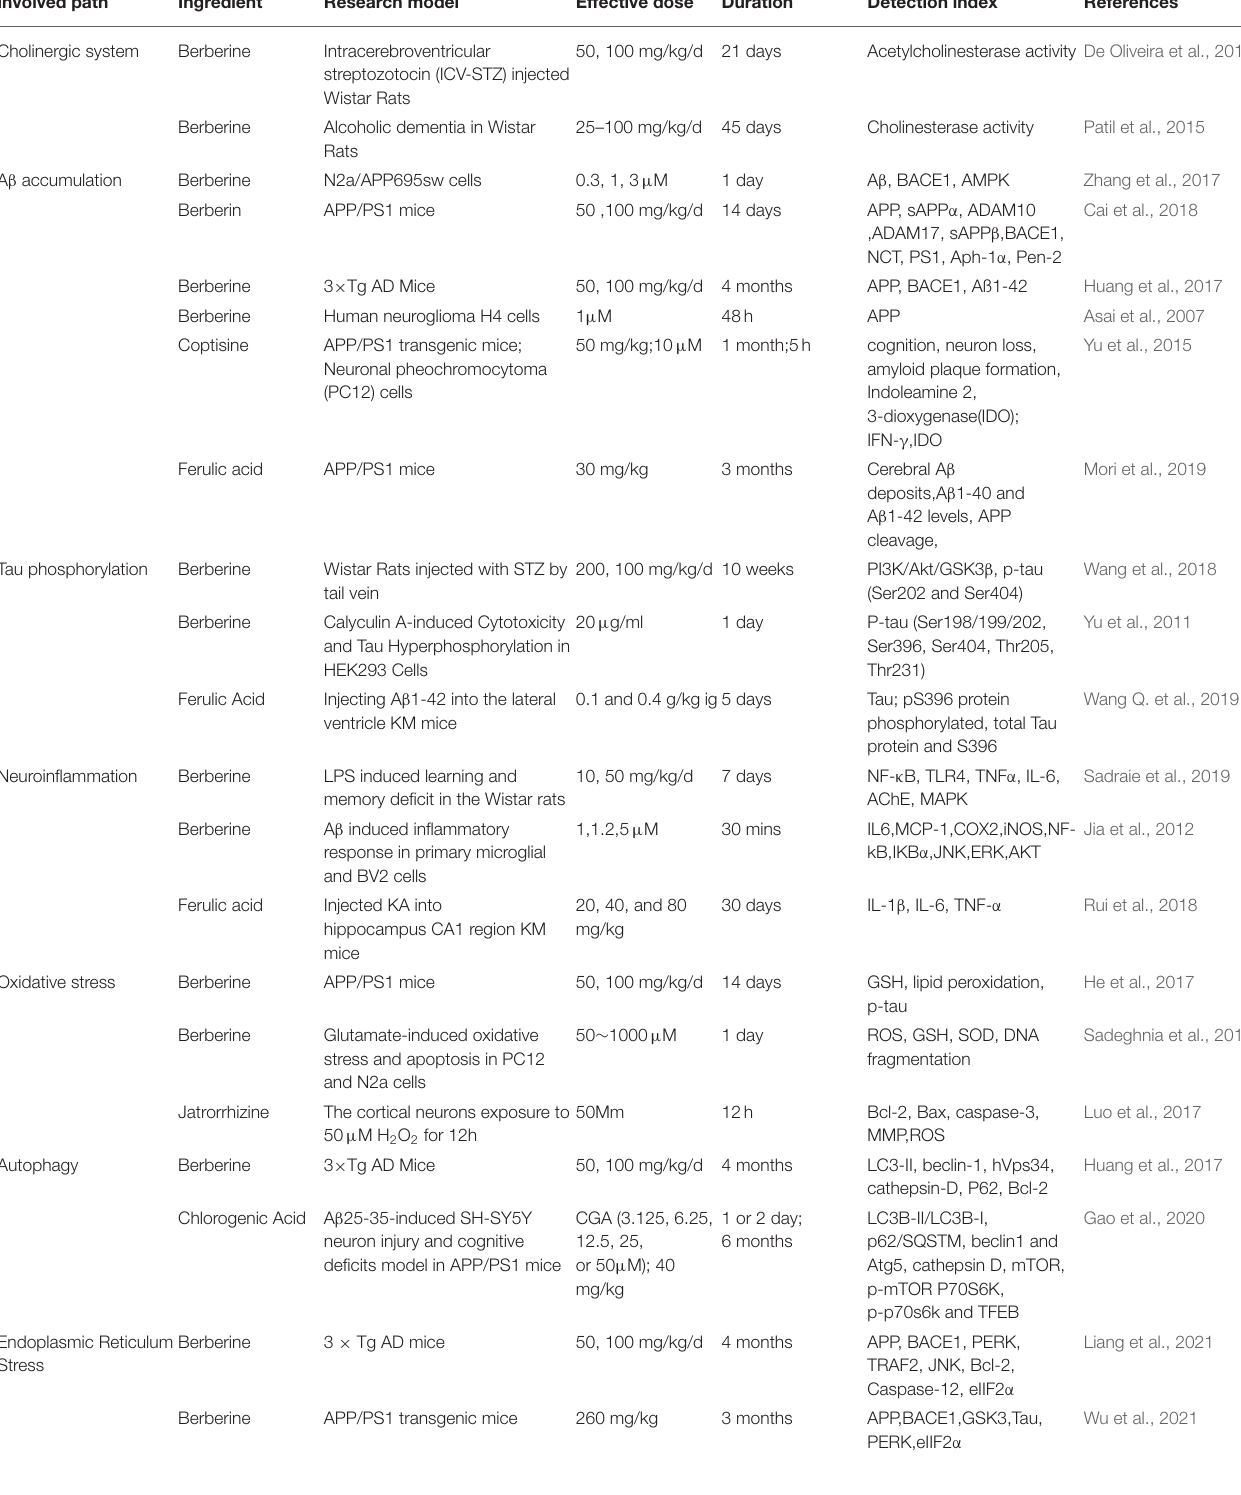
TABLE 6 | CR active ingredients in AD treatment. Involved